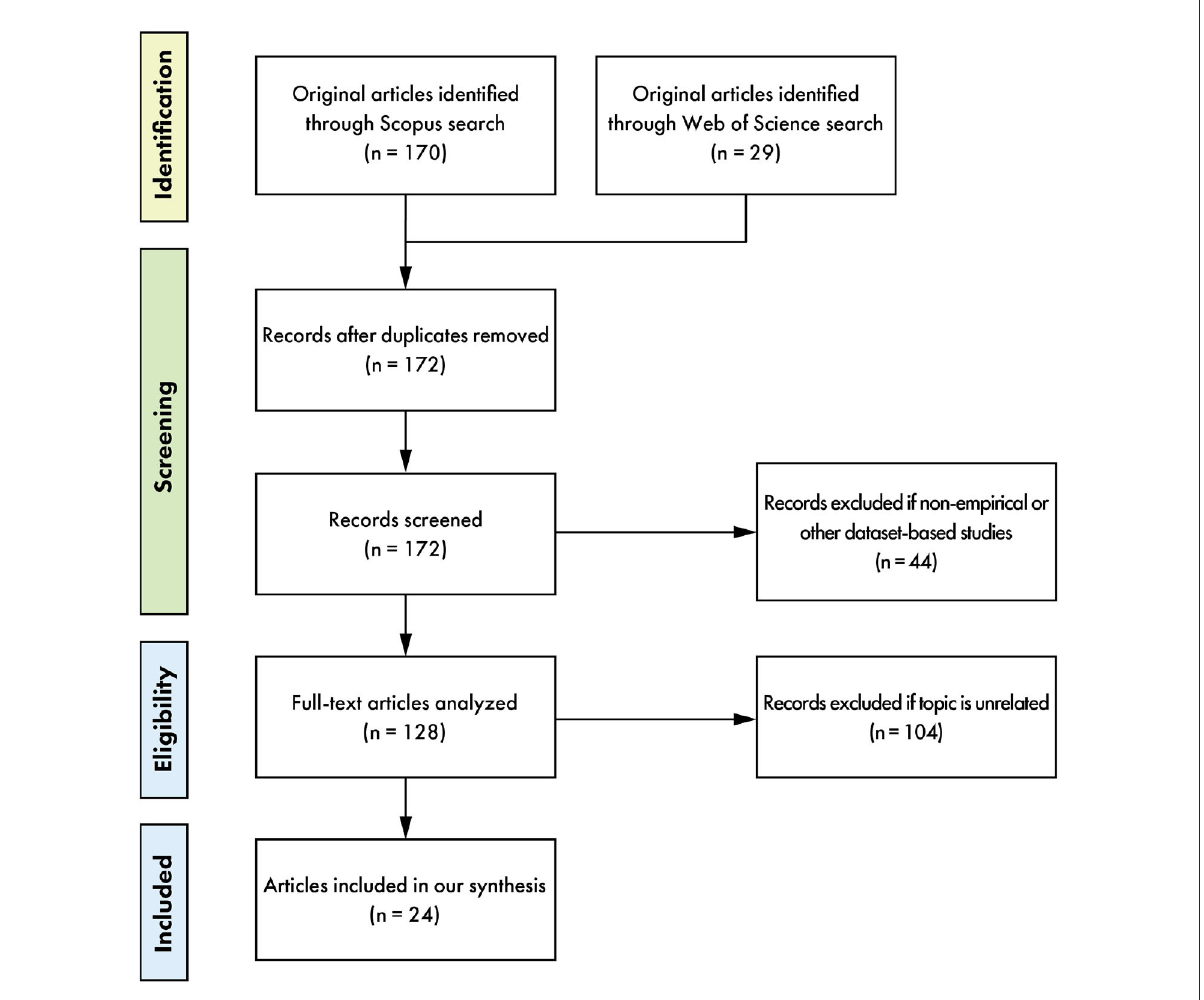
FIGURE3 Screening procedure of social equity literature